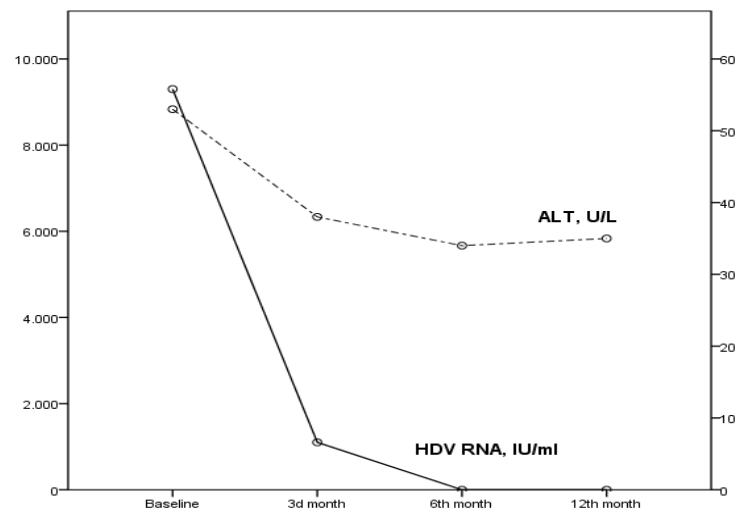
Figure 1. Virological and biochemical response to